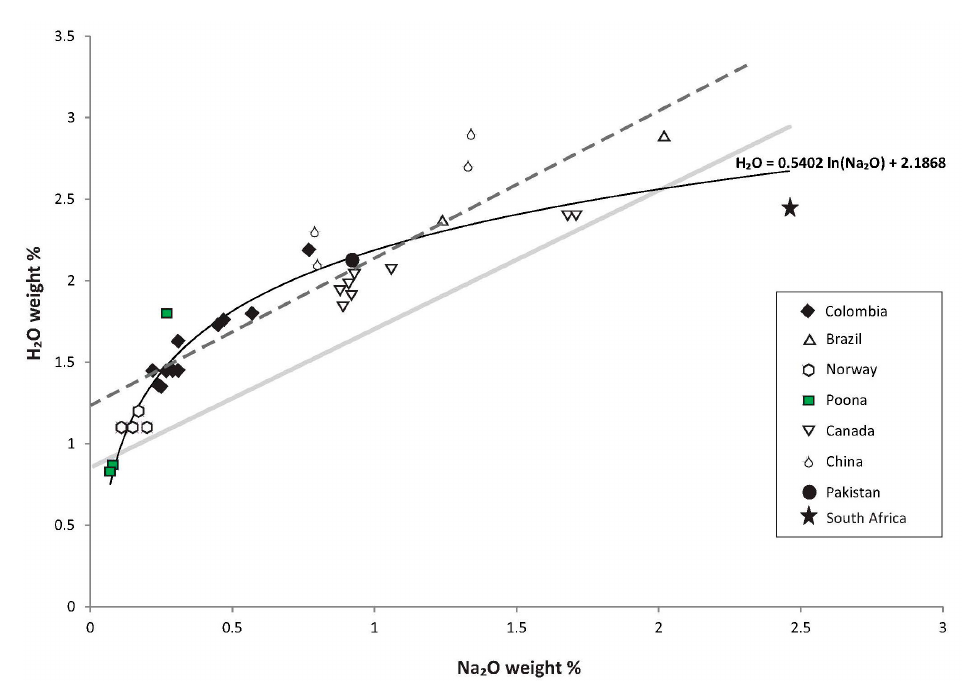
Figure 7. Channel H 2 O versus emerald Na 2 O contents for a variety of emerald deposits. Comparison to the new fit (Equation (3)) is shown in black signature relative to the previously derived equations of [6,26] shown in grey solid and dashed signatures respectively.